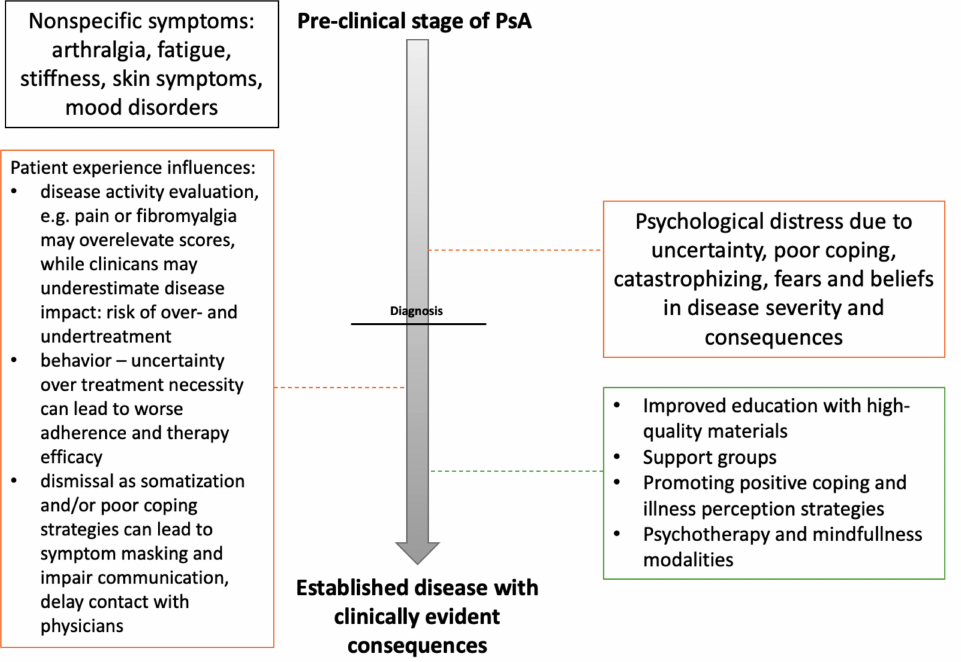
Figure 1. Proposed timeline schematic for psoriatic arthritis. Patients with psoriatic arthritis (PsA) may initially present with non-specific musculoskeletal symptoms that remain unclassified. Misdiagnoses as somatization can occur contributing to delays in diagnosis. Progression of untreated disease in patients with unfavorable coping strategies leads to increasing somatic and psychological distress, which shares a bidirectional link with poor treatment outcomes. Negative consequences are outlined in orange with a focus on management-related dimensions that can, potentially, be modified (dashed line; treatment